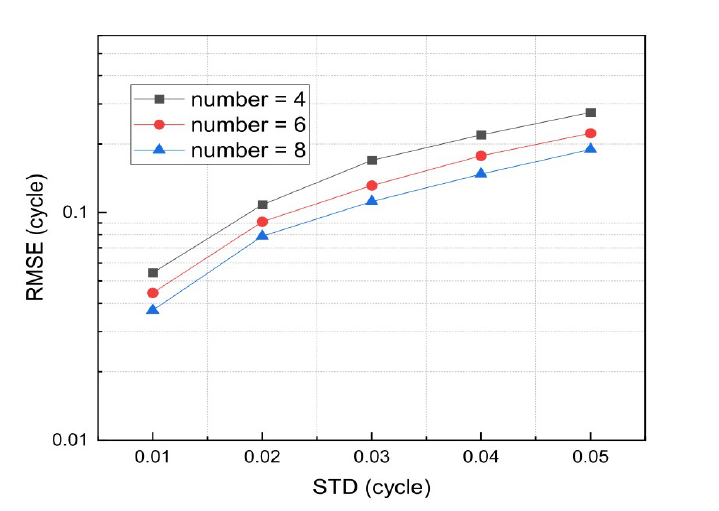
Figure 9. RMSE values of AR by using a different number of